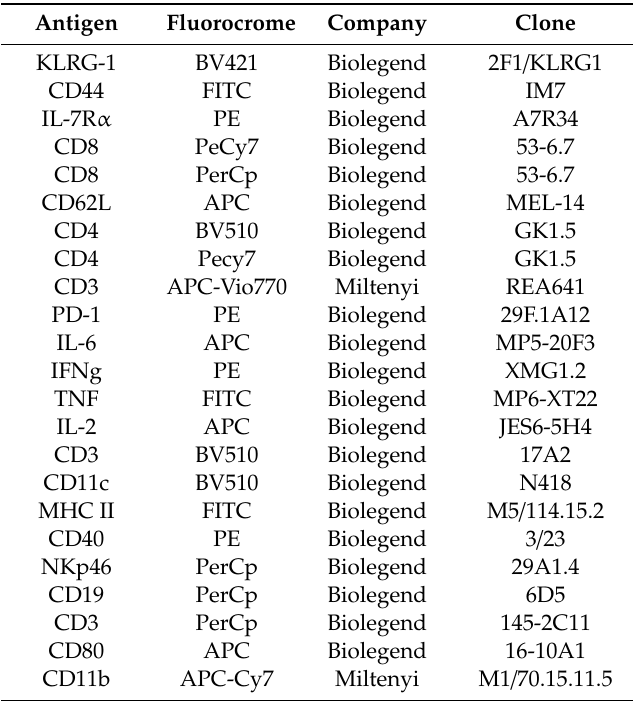
Table 1. Antibodies used in the FACS